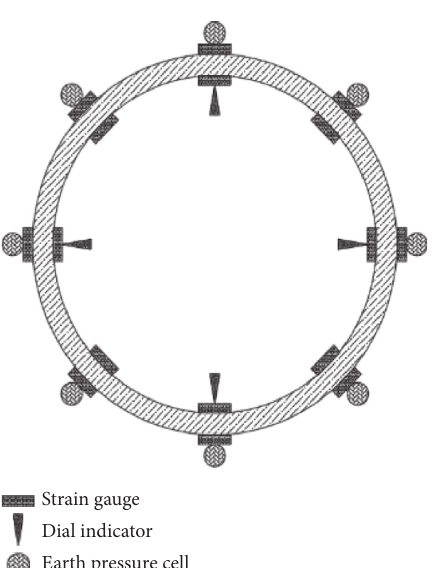
Figure 4: Layout of monitoring